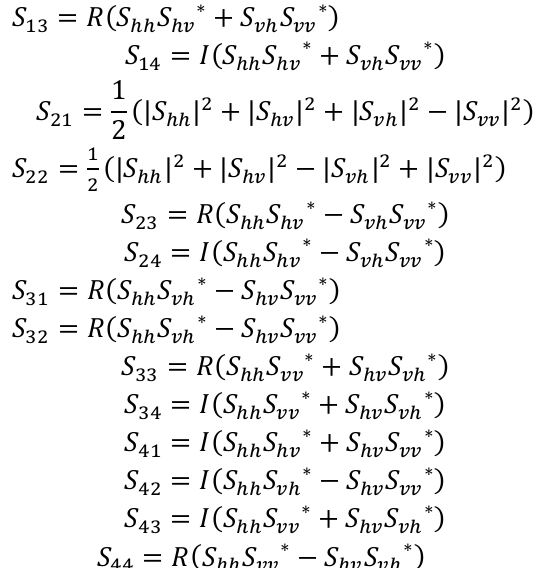
Figure2.3b: Polarization Response of Dihedral corner reflector obtained from developed tool